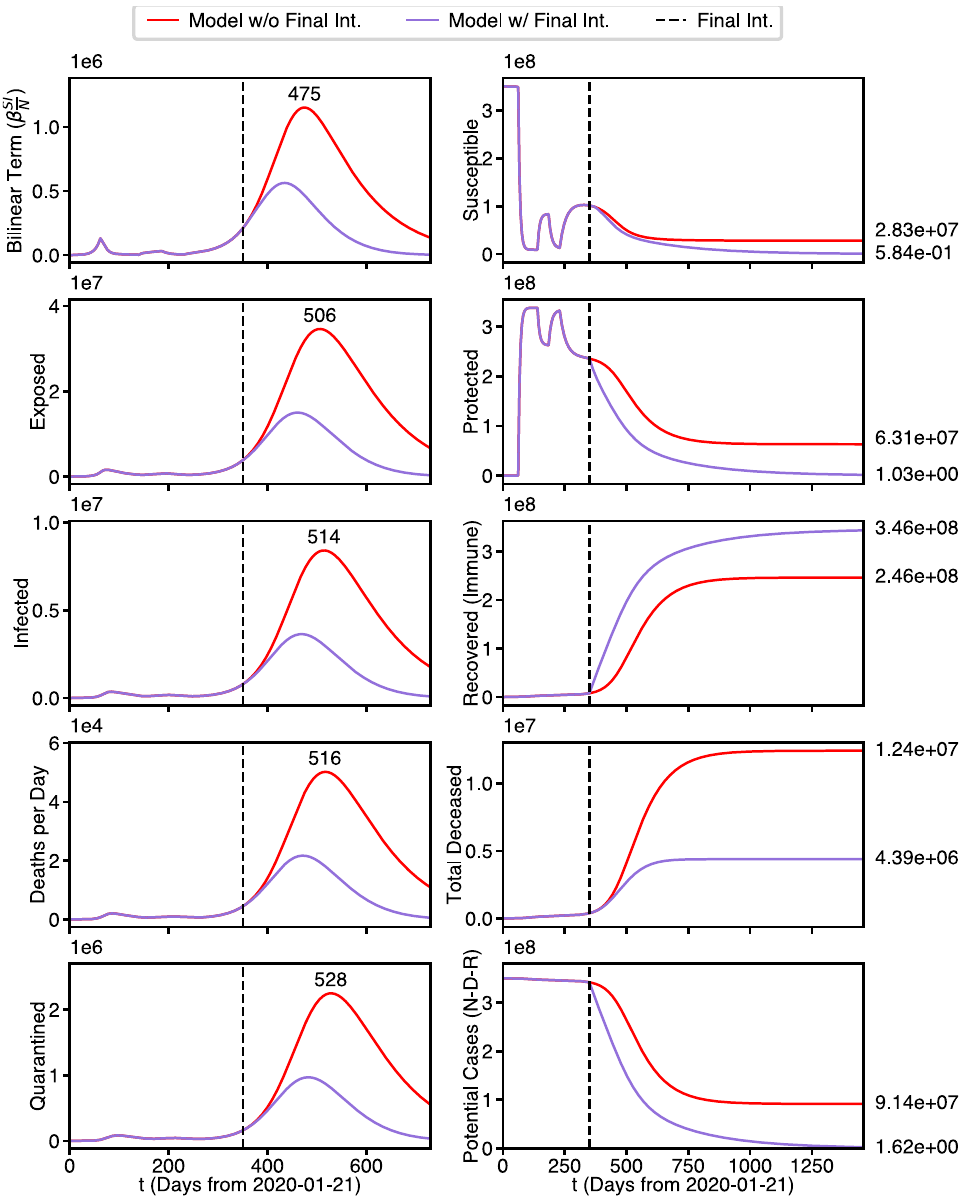
Figure 6. Four year predicted state population waveforms. Best fit parameters with and without a vaccination